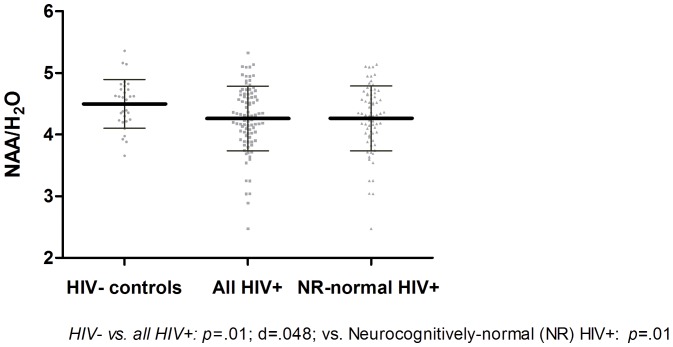
Significant moieties’ difference between theHIV− and HIV+ groups in the Caudate Nucleus Area.